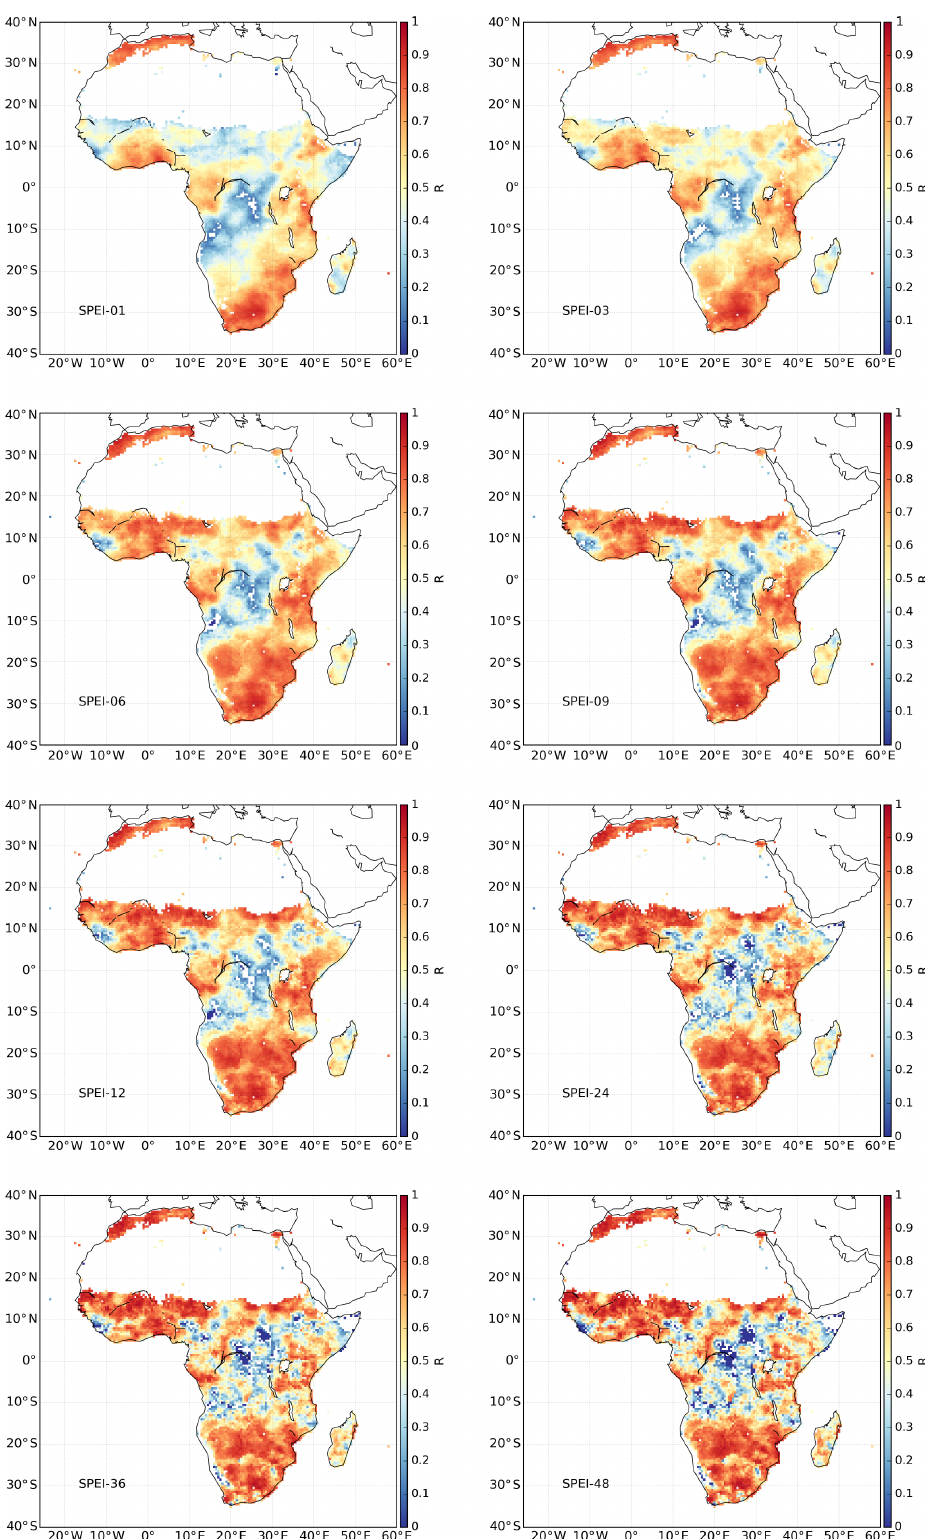
Figure 2. Correlation ( p < 0 . 05) between SPEI-HR and SPEI-CRU, with the number indicating different months.